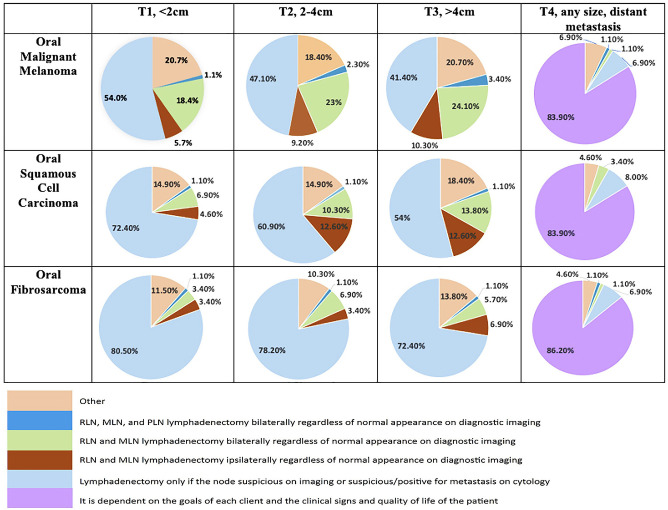
All survey responses for clinician recommendations regarding performing lymph node pathology for common tumor types separated by stage.